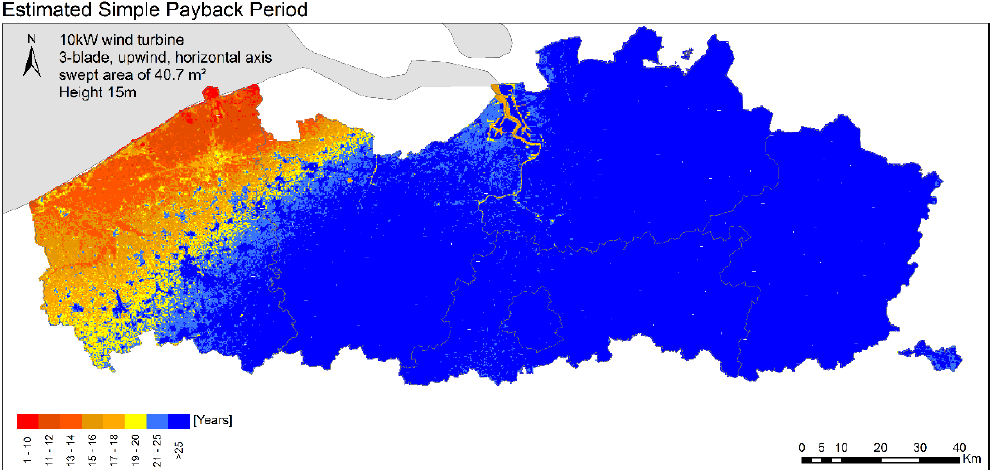
Figure 9. Estimated simple payback period